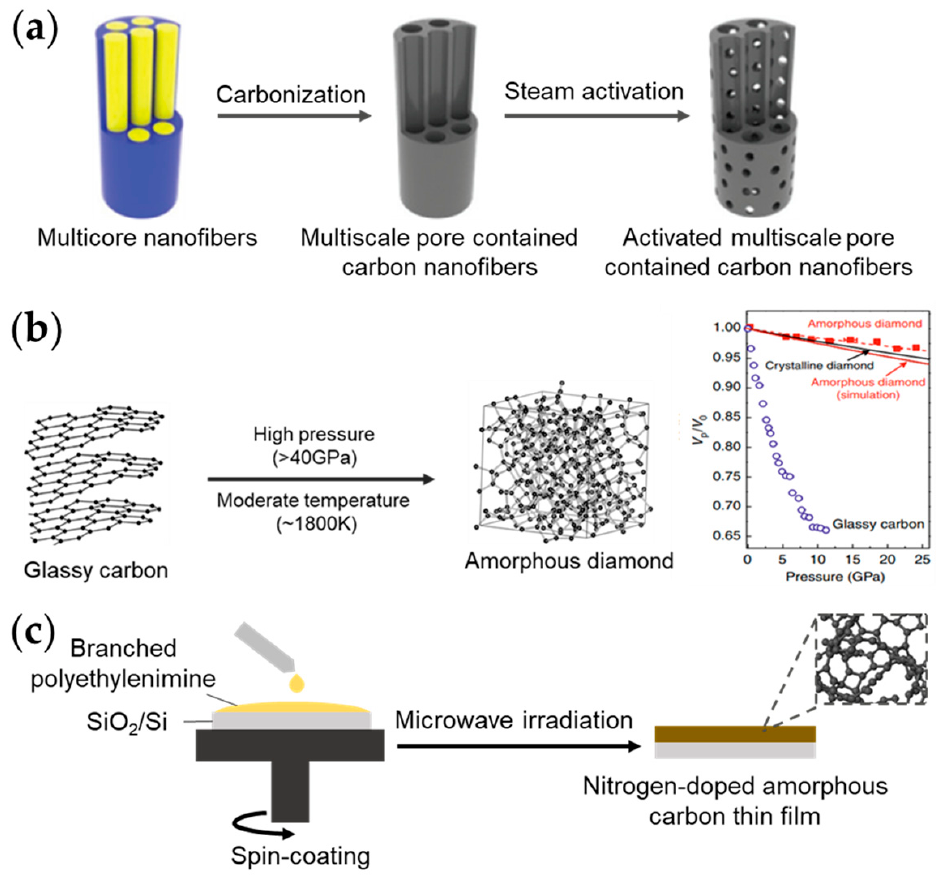
Figure 6. ( a ) High-area carbon nanofibers are synthesized by electrospinning and heat treatment [53]. ( b ) Structure of fully sp 3 -bonded amorphous carbon synthesized from vitreous carbon by in situ